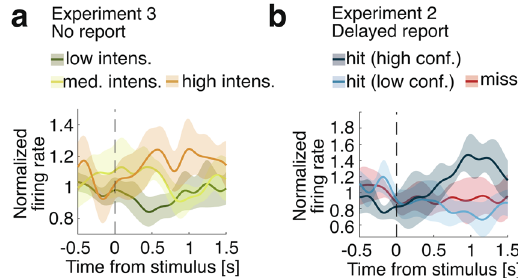
Fig. 3 Average fi ring rates of responsive neurons. Firing rates were normalized using a 0.3 s pre-stimulus baseline. a Normalized fi ring rate for three bins of stimulus intensity (low intensity in dark green, medium intensity in light green, high intensity in orange), averaged across intensity-selective neurons ( N = 14). In Experiment 3, the participant provided no detection or con fi dence report and was let to mind wander. b Normalized fi ring rate for high and low con fi dence for hits (blue) and for misses (red), averaged across all detection- and con fi dence- selective neurons with higher fi ring rates for hits ( N = 10). In Experiment 2, the participant waited at least 1 s before reporting detection and con fi dence